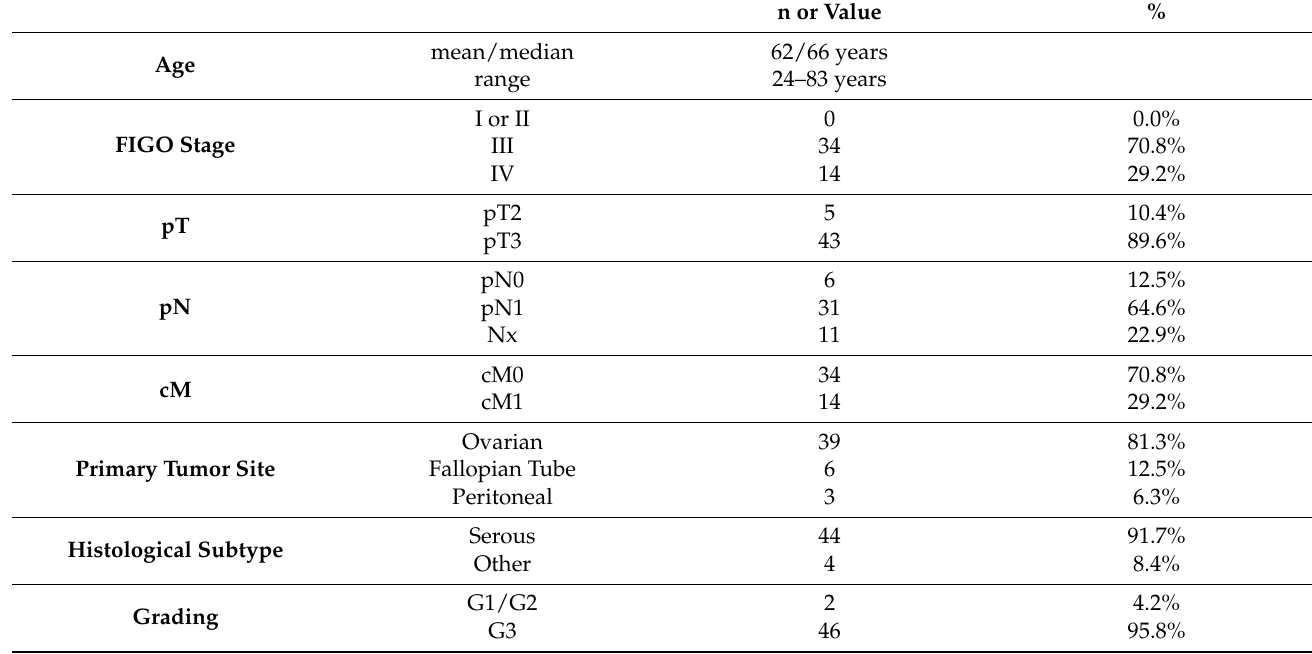
Table 2. Patient